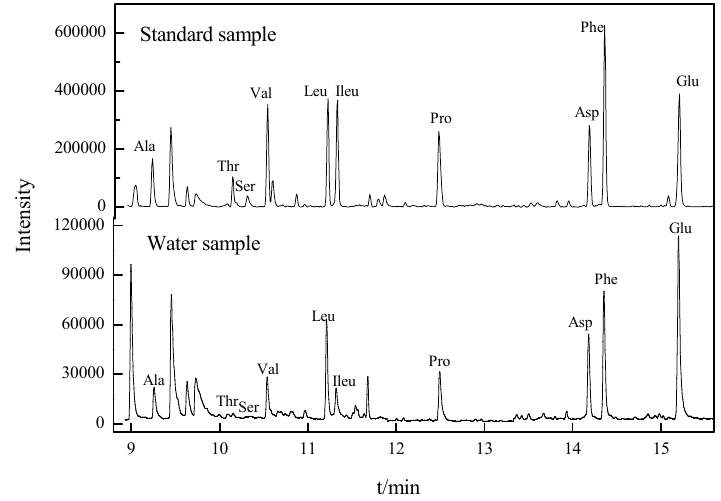
Figure 2. Gas chromatography–mass spectrometry (GC-MS) chromatogram of standard free amino acids (FAAs) and raw water sampled from JX waterworks.